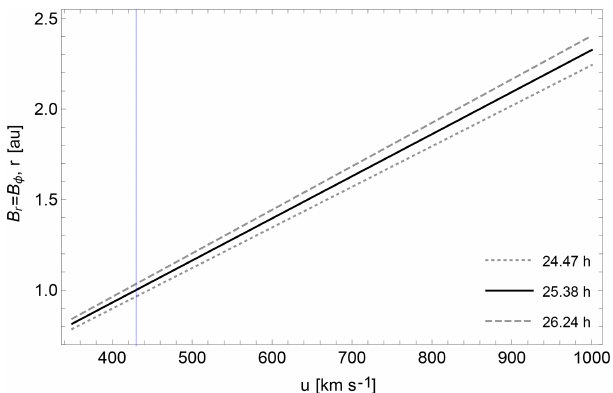
Figure 3. Heliocentric distance r in astronomical units (au) at which the spiral angle of the interplanetary magnetic field reaches 45 ◦ to the radial direction from the Sun ( B r = B φ ). The curves are plotted as a function of the solar wind speed in units of kms − 1 for 3 differ- ent rotation rates, a period of 26.24h (upper curve), 25.38h (middle curve), and 24.47h (lower curve). A typical value of the solar wind speed is 430kms − 1 (shown by a vertical thin